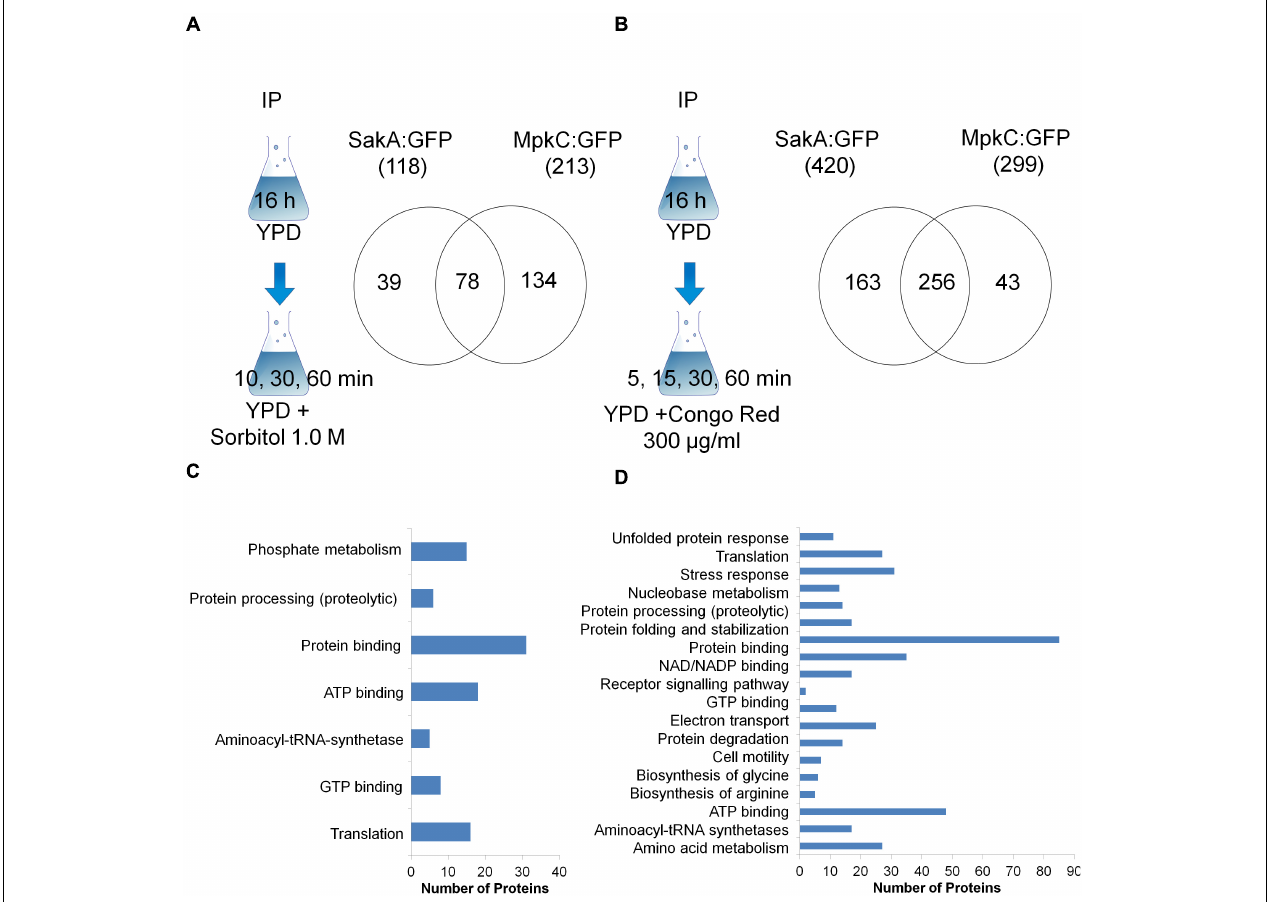
FIGURE 1 | Scheme and Venn diagram of the pull-down experiments for proteins that interact with SakA:GFP and MpkC:GFP upon osmotic (A) and cell wall stresses (B) . A summary of the FunCat terms over-represented (adjusted p -value < 0.05) for proteins observed as interacting with SakA:GFP and MpkC:GFP upon osmotic (C) and cell wall stresses (D) . For the full list refer to Supplementary Tables S1–S10